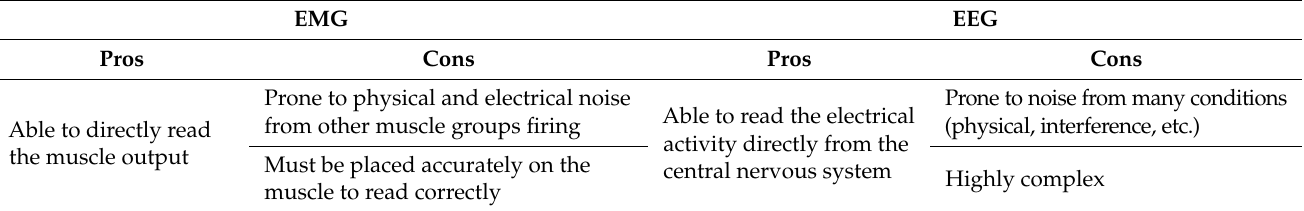
Table 2. Comparing EMG and EEG used as biosignal methods for assistive hand exoskeletons [8]. EMG EEG Pros Cons Pros Cons Prone to physical and electrical noise Prone to noise from many conditions from other muscle groups firing Able to read the electrical (physical, interference, etc.) Able to directly read activity directly from the the muscle output Must be placed accurately on the central nervous system Highly muscle to read correctly